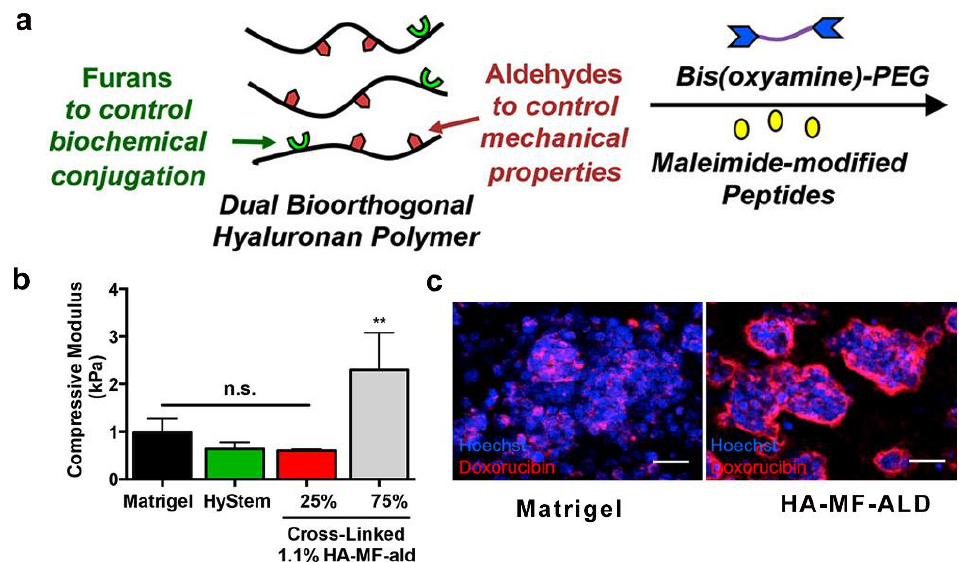
Figure 13. Hyaluronan-based hydrogels with oxime and Diels − Alder chemistry to culture breast cancer spheroids. ( a ) Schematic of preparation of hyaluronic-acid-based hydrogels. ( b ) Tunable mechanical performance of hyaluronic acid-based hydrogels (** significance level of p < 0.01, n.s. = not significant). ( c ) Hyaluronic-acid-based hydrogels for culturing breast cancer spheroids (Reprinted/adapted with permission from Ref. [93], 2017, Baker et al.).